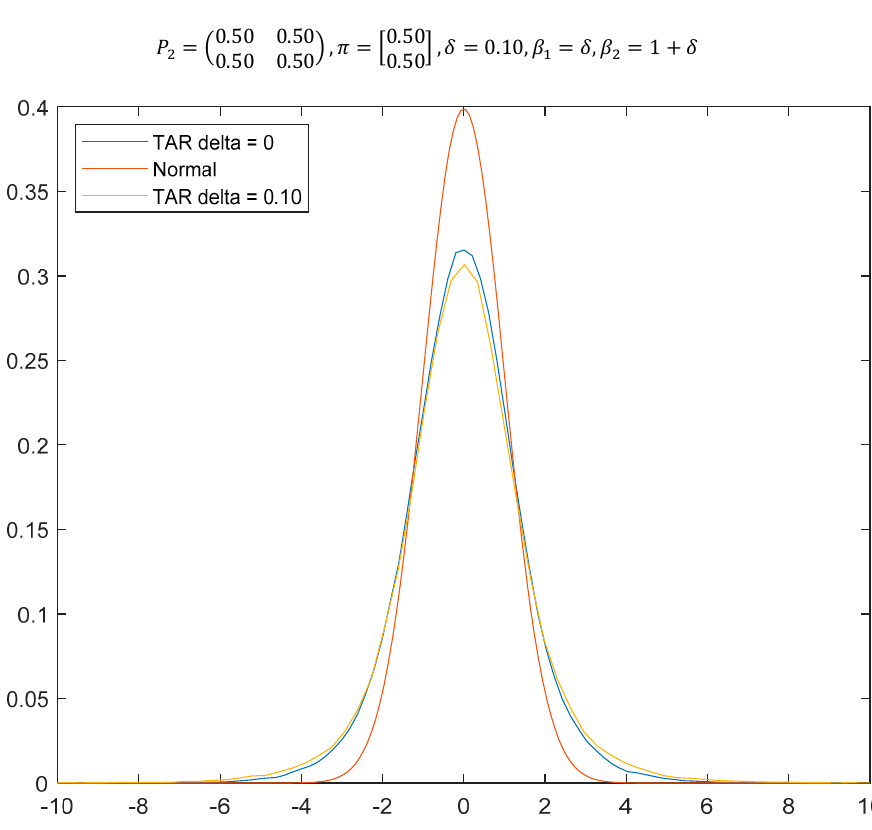
1 as the transition matrix.